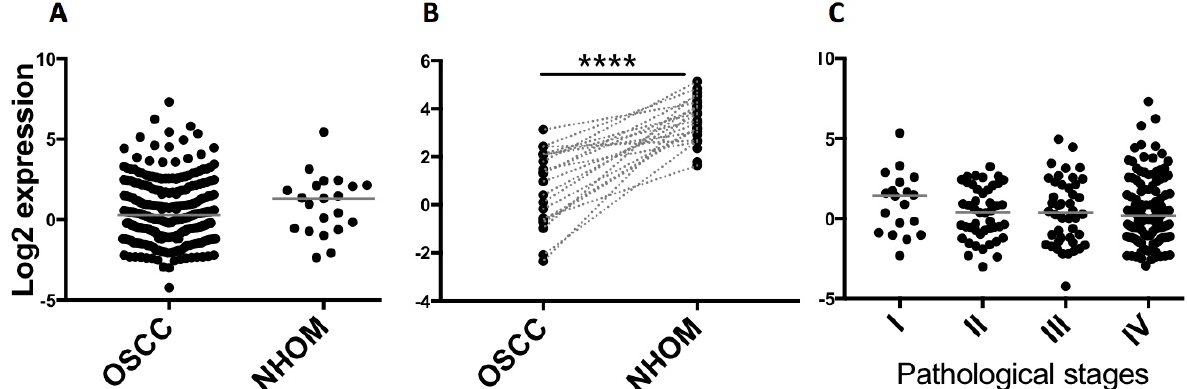
Figure 3. Graphs showing expression of miR-204 in OSCC (TCGA data): ( A ) No significant difference between miR204 expression in OSCC compared with normal tissues (Mann-Whitney test; n = 251 OSCC, n = 21 NHOM). ( B ) A significant difference was detected between miR-204 expression in matched OSCC-NHOM cases (paired t -test; n = 20, matched cases are linked by a dotted line, **** p < 0.00005). ( C ) No significant difference in miR-204 expression among different OSCC stages (Kruskal-Wallis test showed no significant difference between different stages, although a trend for decreased expression from stage I to more advanced stages could be observed).